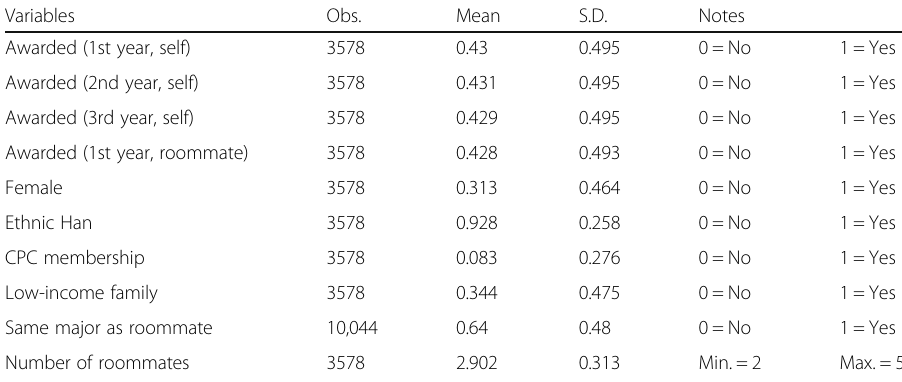
Table 1 Summary statistics for key